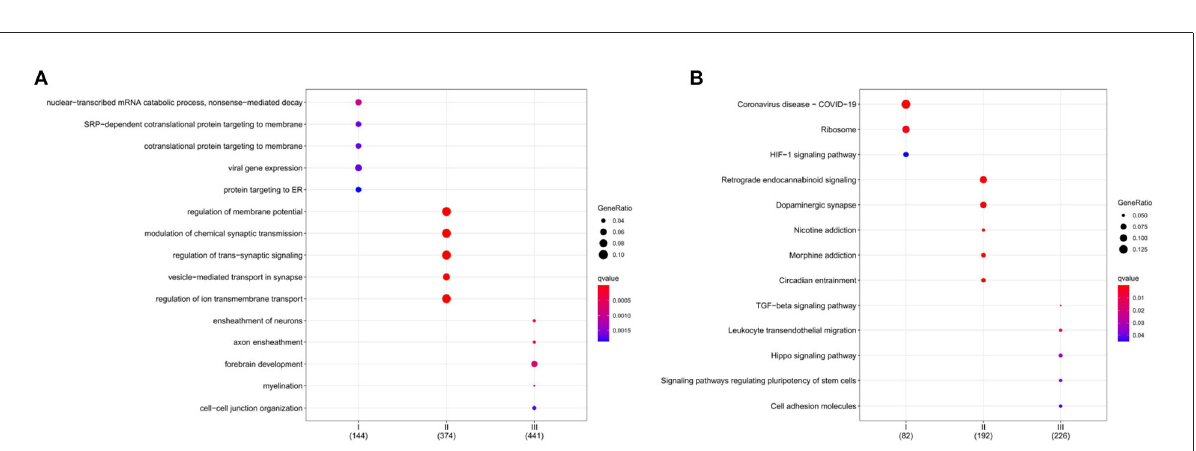
FIGURE8 Functional characterization of a subgroup. (A) BP enrichment for each subgroup. (B) KEGG enrichment for each subgroup. The color indicates significance. The size of the circle means Gene